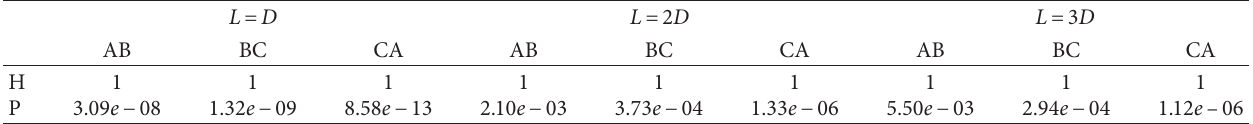
Table 5: Individual T test results between Groups A, B, and C ( H � 1 suggests the close interrelationship within pressure fluctuating pattern).